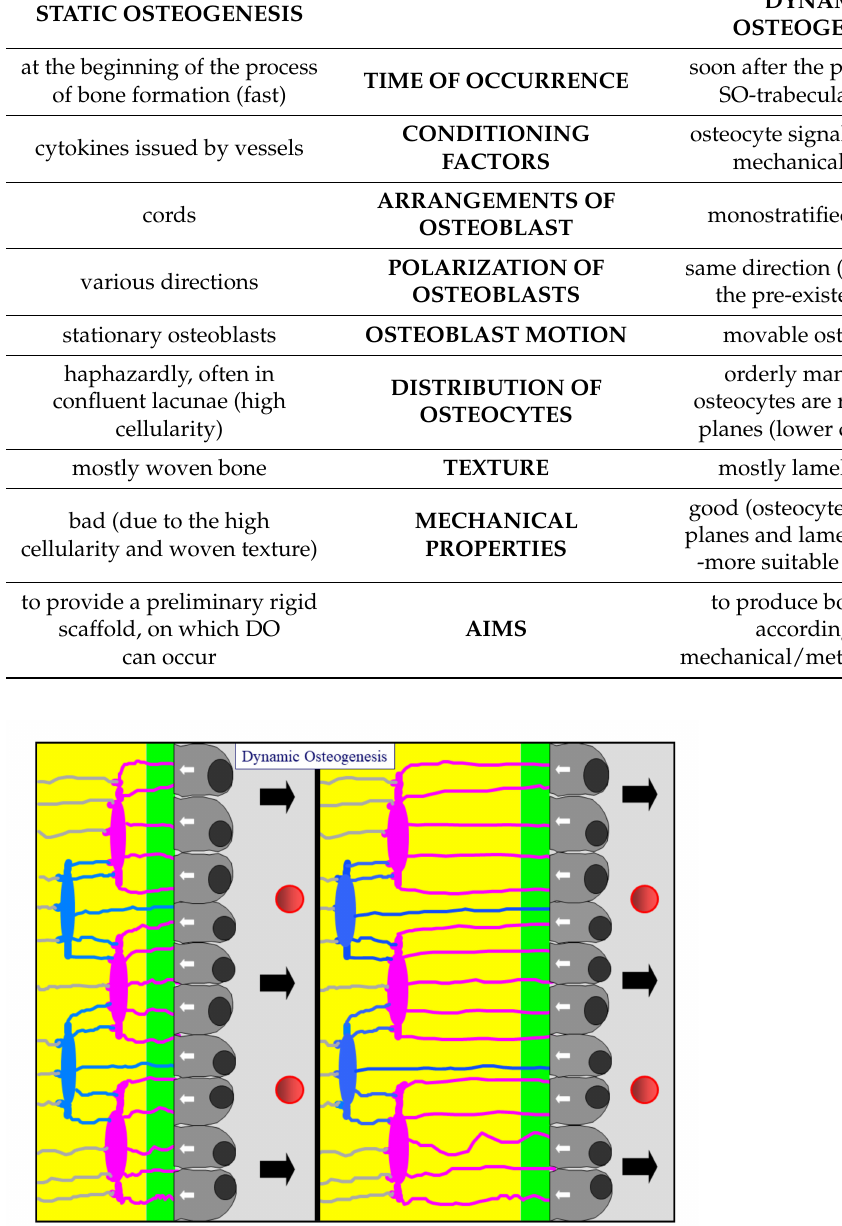
Figure 2. A diagram showing an osteoblastic lamina during DO. From left to right, the osteoblastic lamina moves away (as indicated by black arrows) from the mineralized front (green bar) to the vessels (red circles). The white arrows indicate the osteoblast polarization side. Two generations of almond-like shaped osteocytes (located in planes) are enclosed inside the bone (see text for further